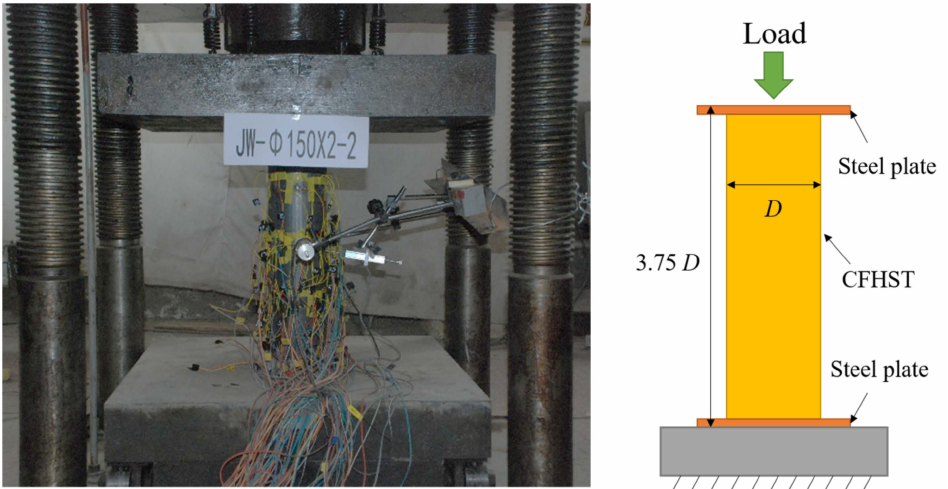
Figure 4. Loading